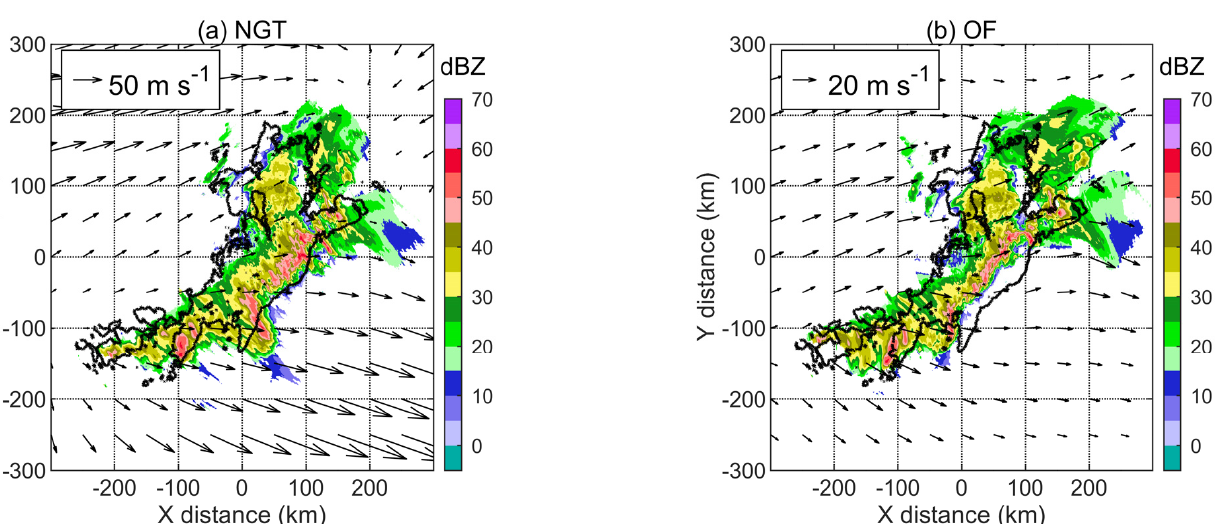
Figure 11. CSI of the prediction by NGT and OF for ( a ) Z > 20 dBZ, ( b ) Z > 30 dBZ, ( c ) Z > 40 dBZ, and ( d ) NGT—OF. The prediction starts at 14:25 UTC on 17 May 2020. Table 2. Skill scores of the two methods for 60 min prediction. The target time is 15:22 UTC on 17 May 2020. Threshold ( dBZ )